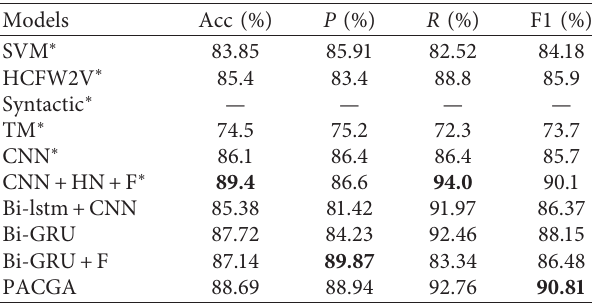
Table 2: Experimental results on Puns dataset. Best results are in bold. The results with superscript ∗ are imported from the literature [3, 15–17].